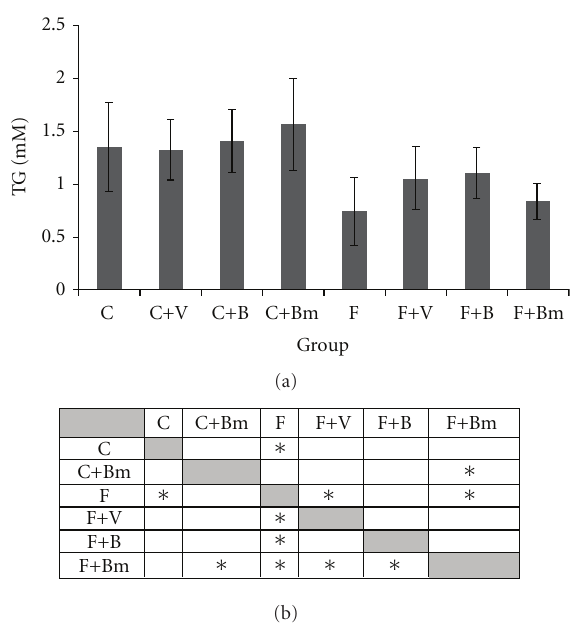
Figure 4: E ff ects of vanadium complex V, B, and Bm on plasma uric acid of Wistar rats. Data are presented as mean ± SD for n = 6. (b) Statistical di ff erences between groups P < 0.05.